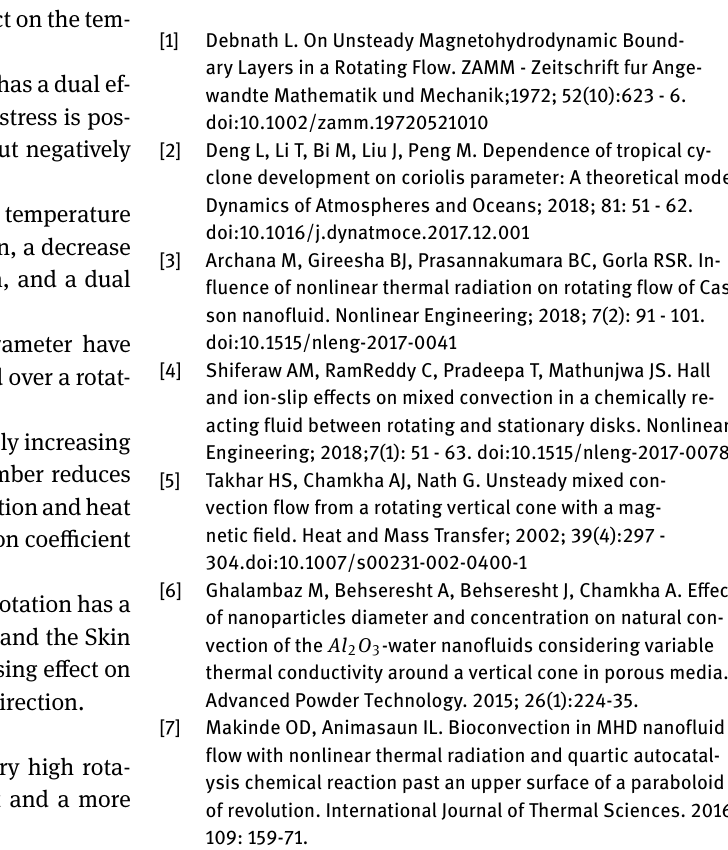
Table 5: Variation of quantities of interest with rotation parameter m = 0.3000 , χ = 0.2500 , G = 3.0 , Pr = 10 , and β = 0.1 K C fx C fz N ux 0.001 -0.2037 0.0501 0.1 -0.2044 0.0666 0.2